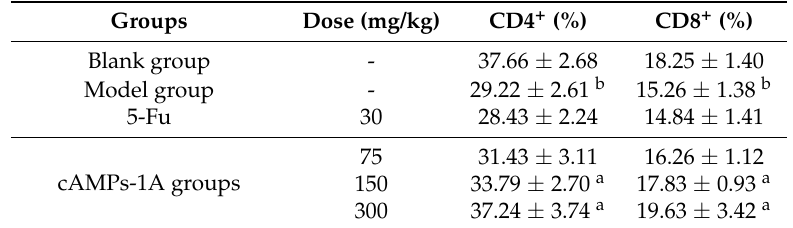
Table 2. Effects of cAMPs-1A on the distribution of T cells subsets in peripheral blood. Groups Dose